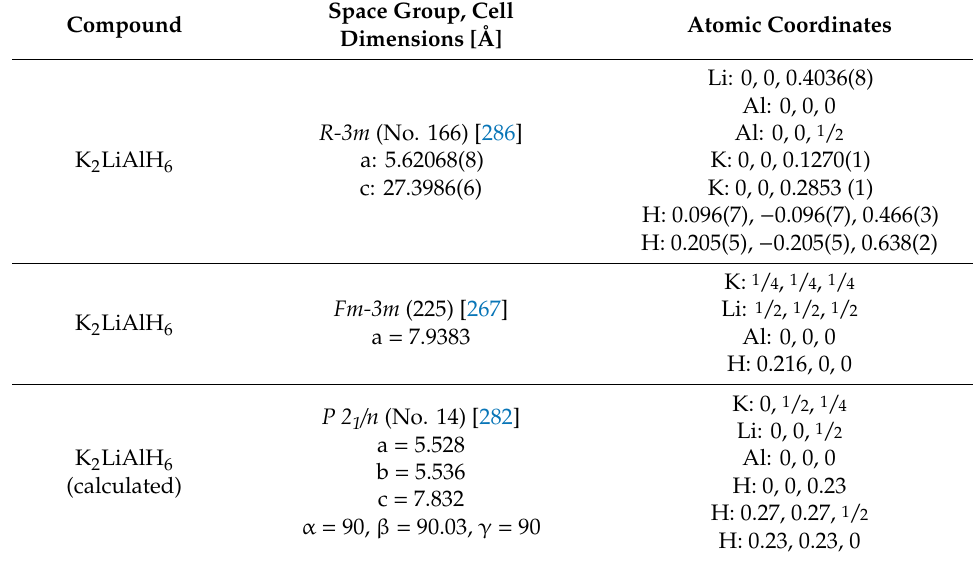
Table 15. Crystallographic data of Li-K mixed